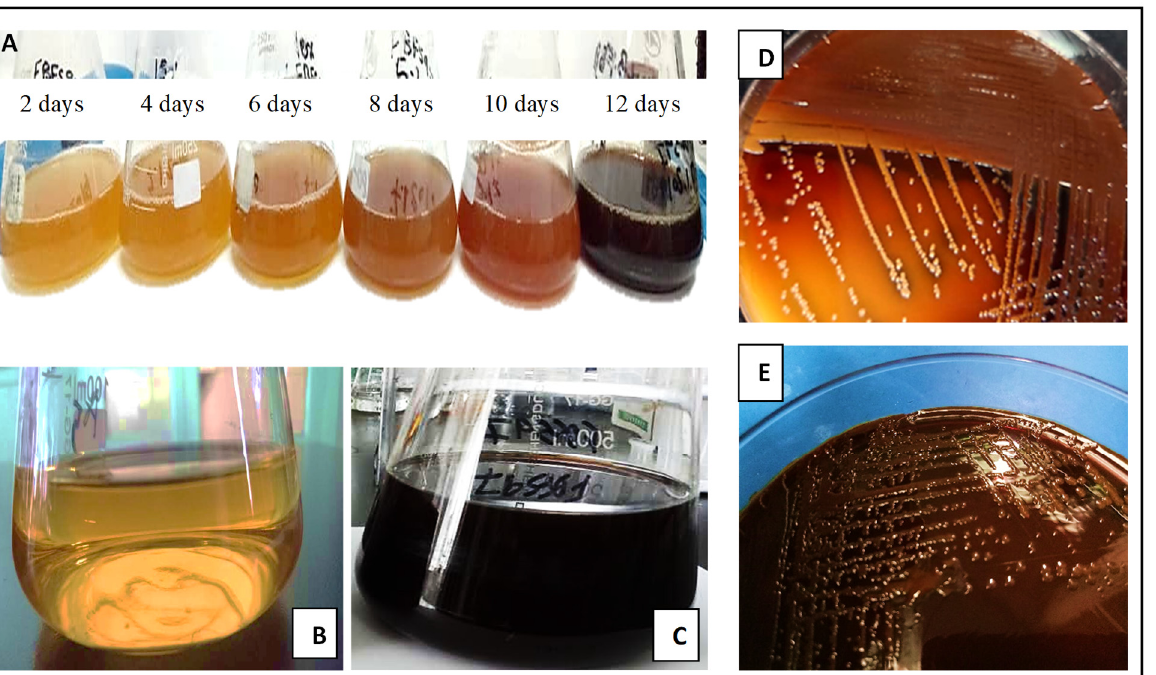
Figure 2. Melanin pigment of G. oxydans FBFS 97 during the extraction process ( A ), purified melanin powder ( B , C ).